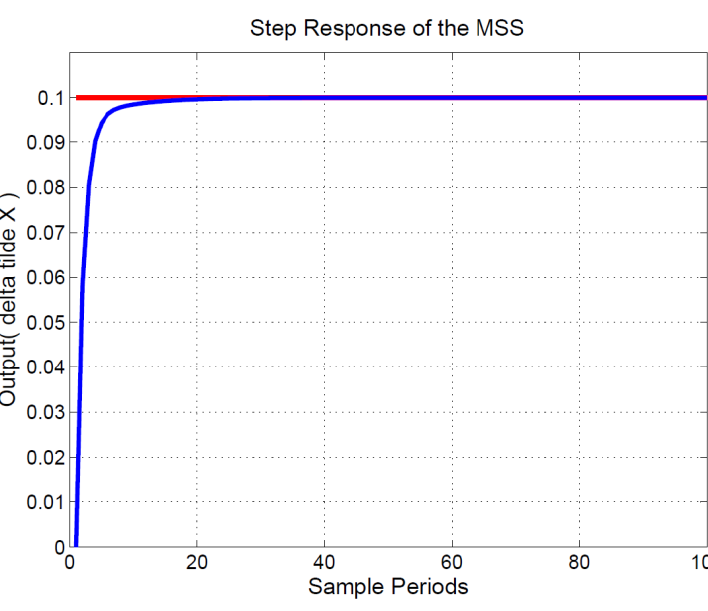
Figure 8. Step response of the MSS.